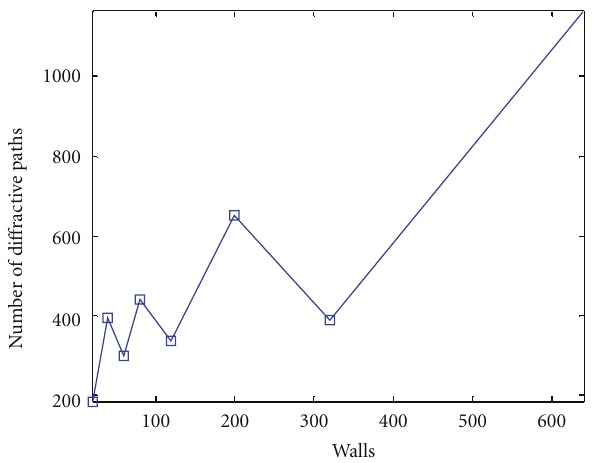
Figure 17: Number of di ff ractive paths versus the complexity of the environment (measured by the number of walls) in which experiments are done.